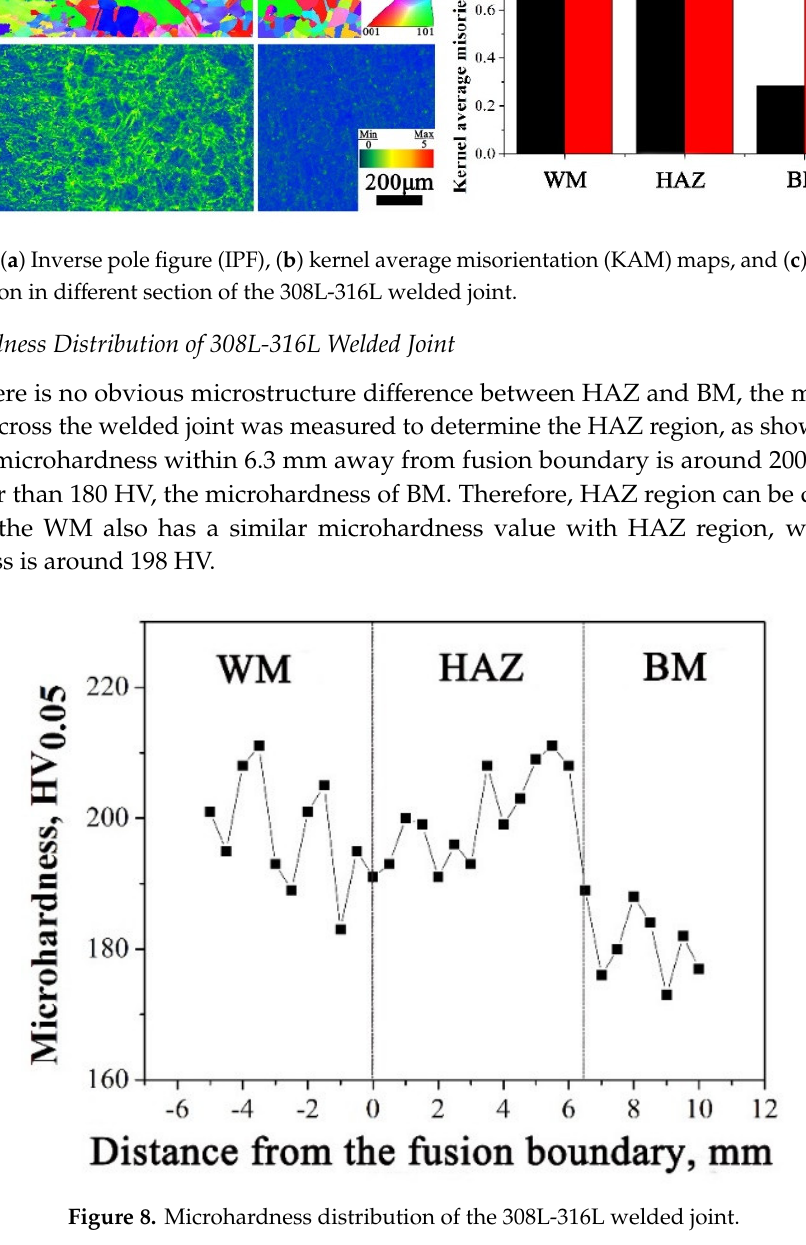
Figure 9. Potentiodynamic polarization curves of different sections in the 308L-316L welded joint.